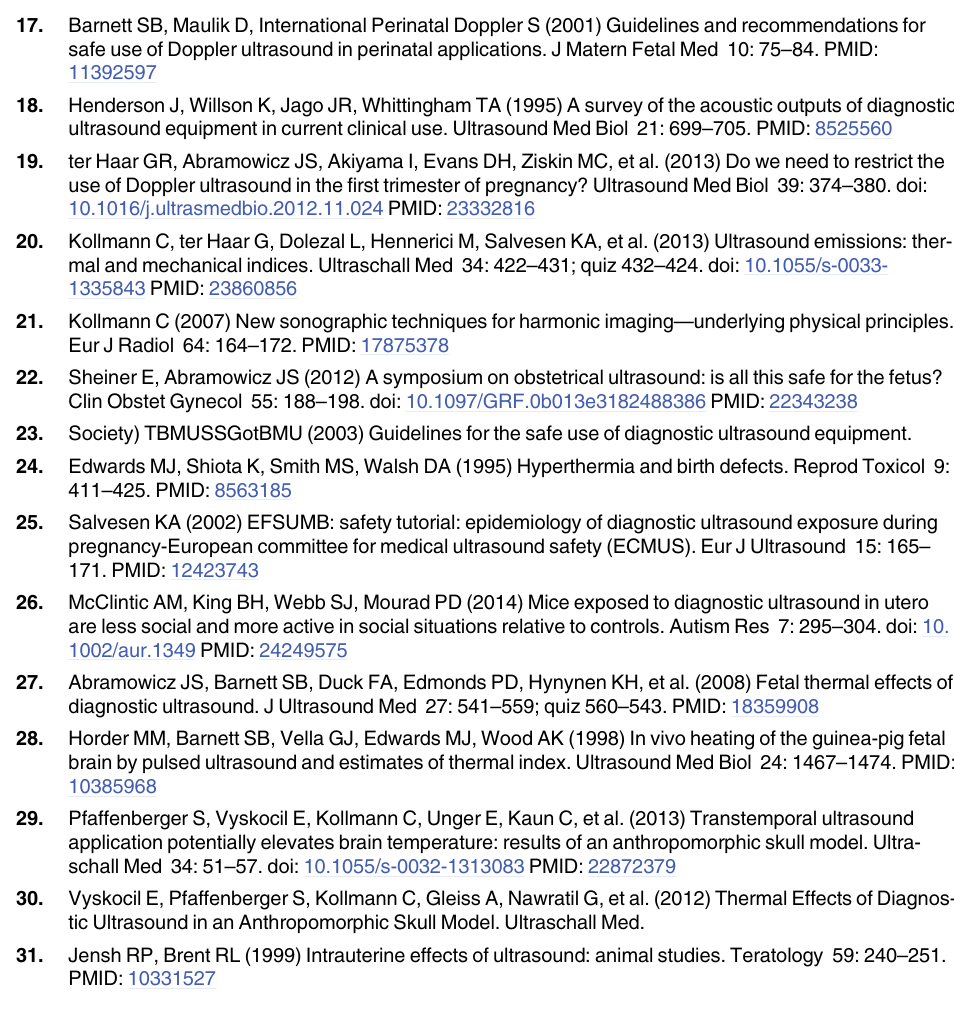
PLOS ONE | DOI:10.1371/journal.pone.0135717 August 24,